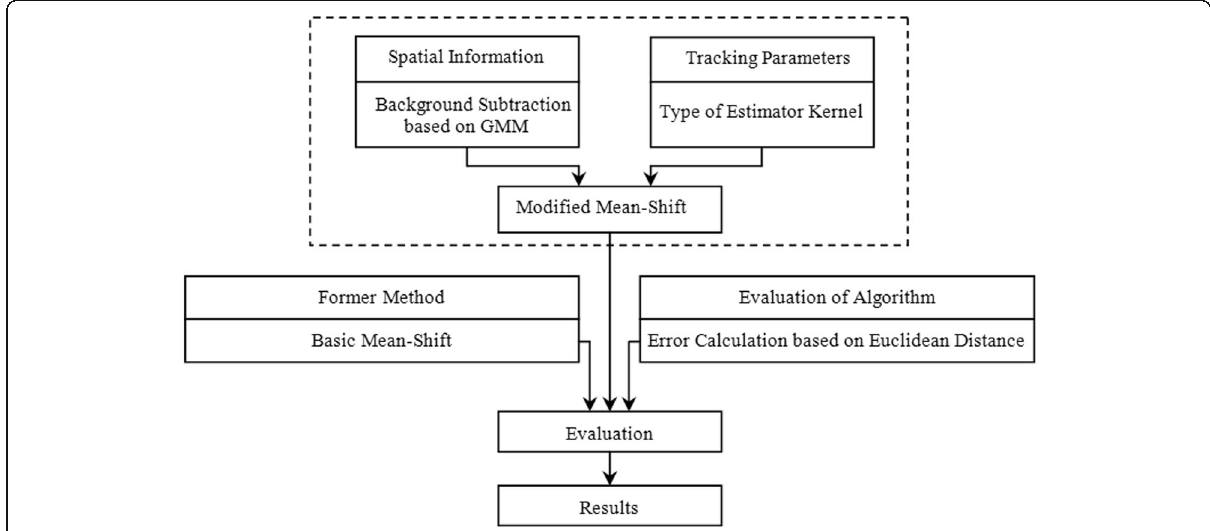
Fig. 14 General scheme of proposed method and evaluation of algorithm to achieve results